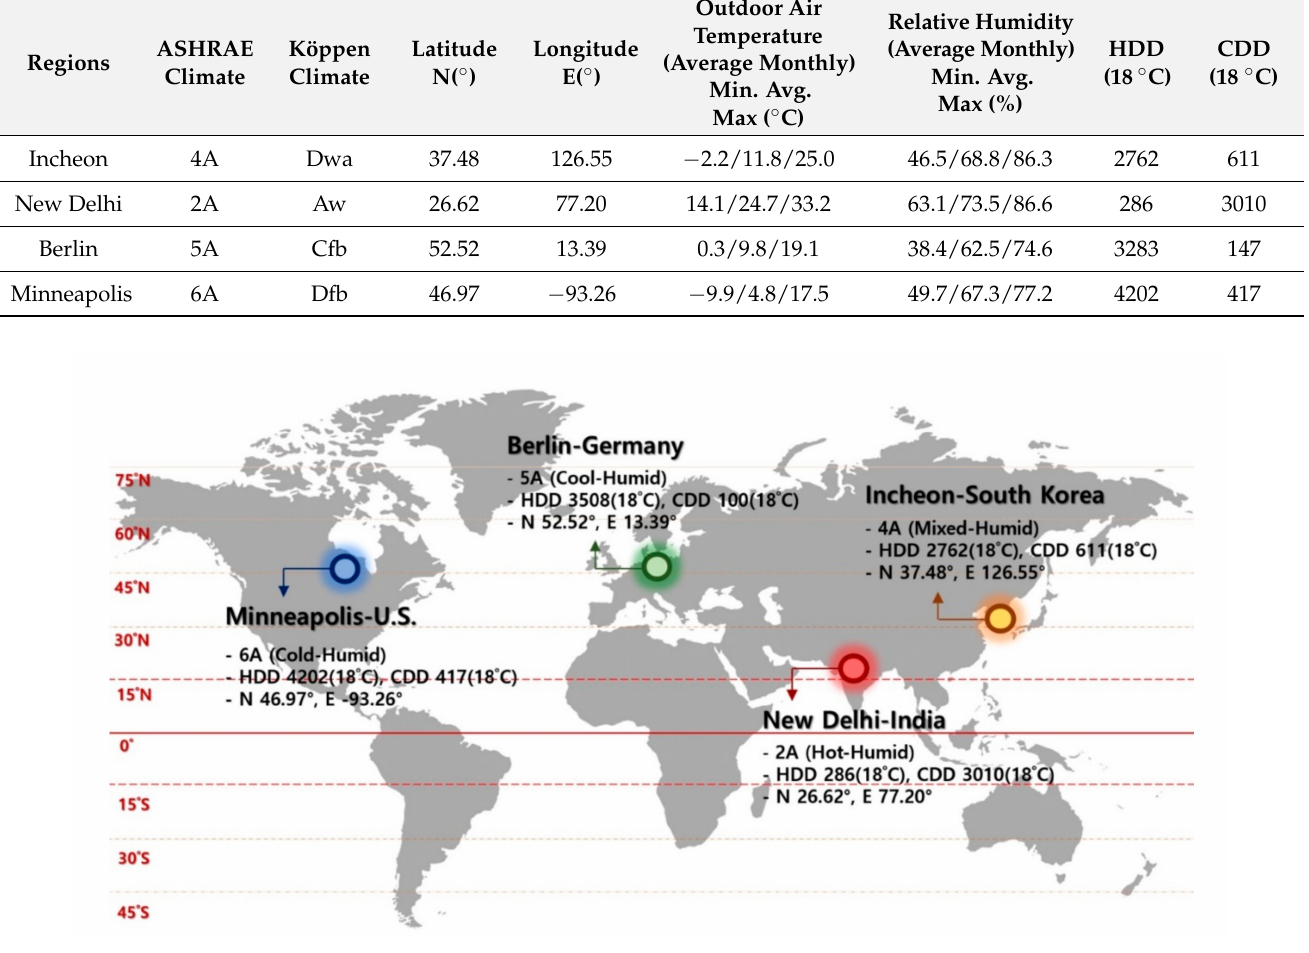
Figure 7. Selection of the four regions for the EnergyPlus